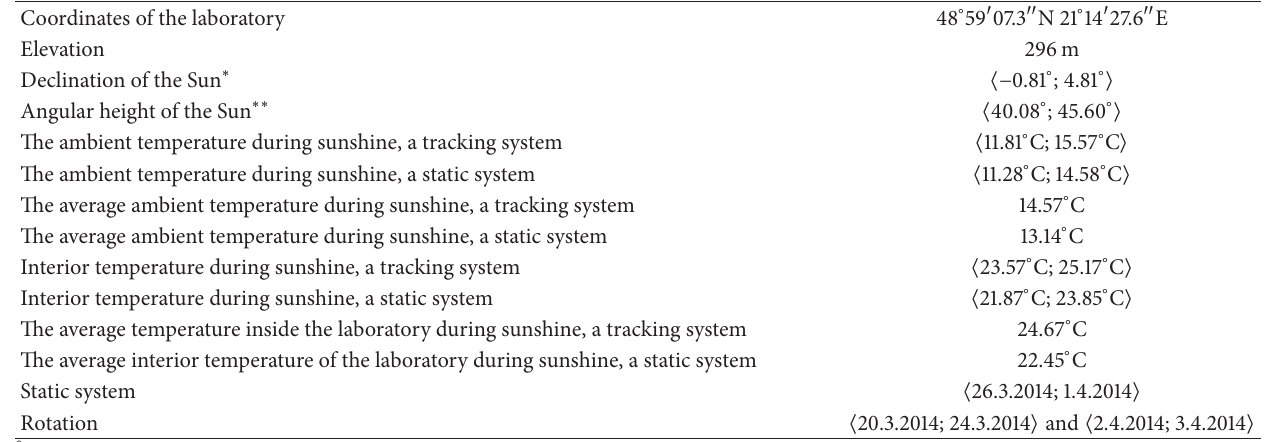
Table 1: The conditions during the experiment